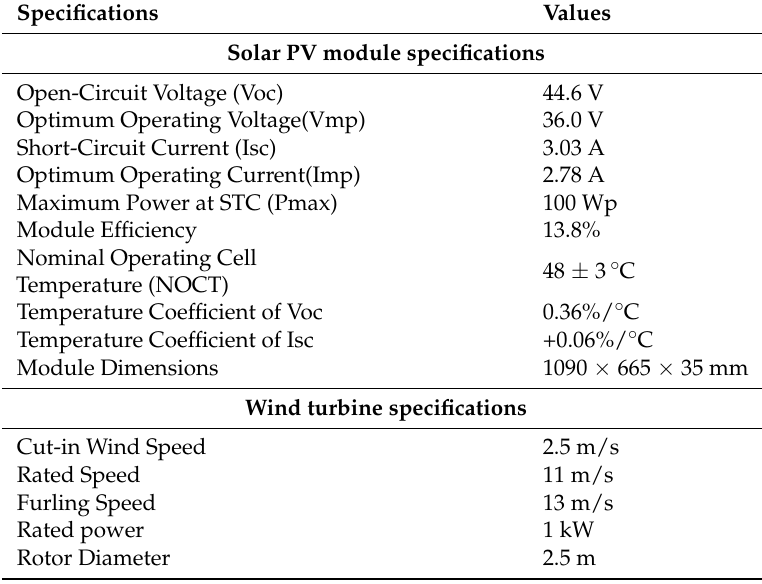
Table 5. Technical Specifications of System